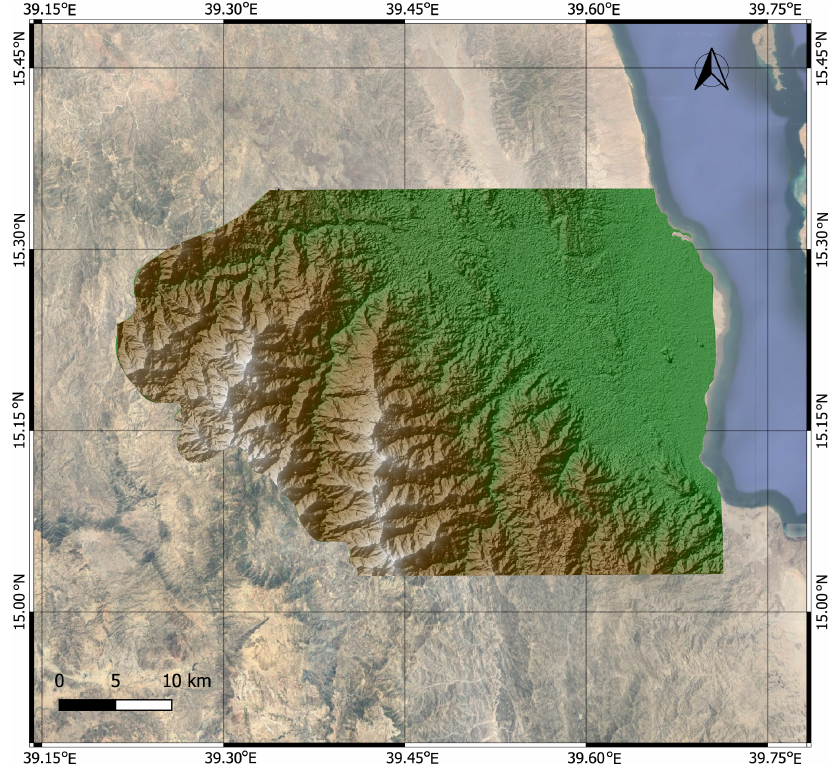
Figure 2. Digital elevation model of the study